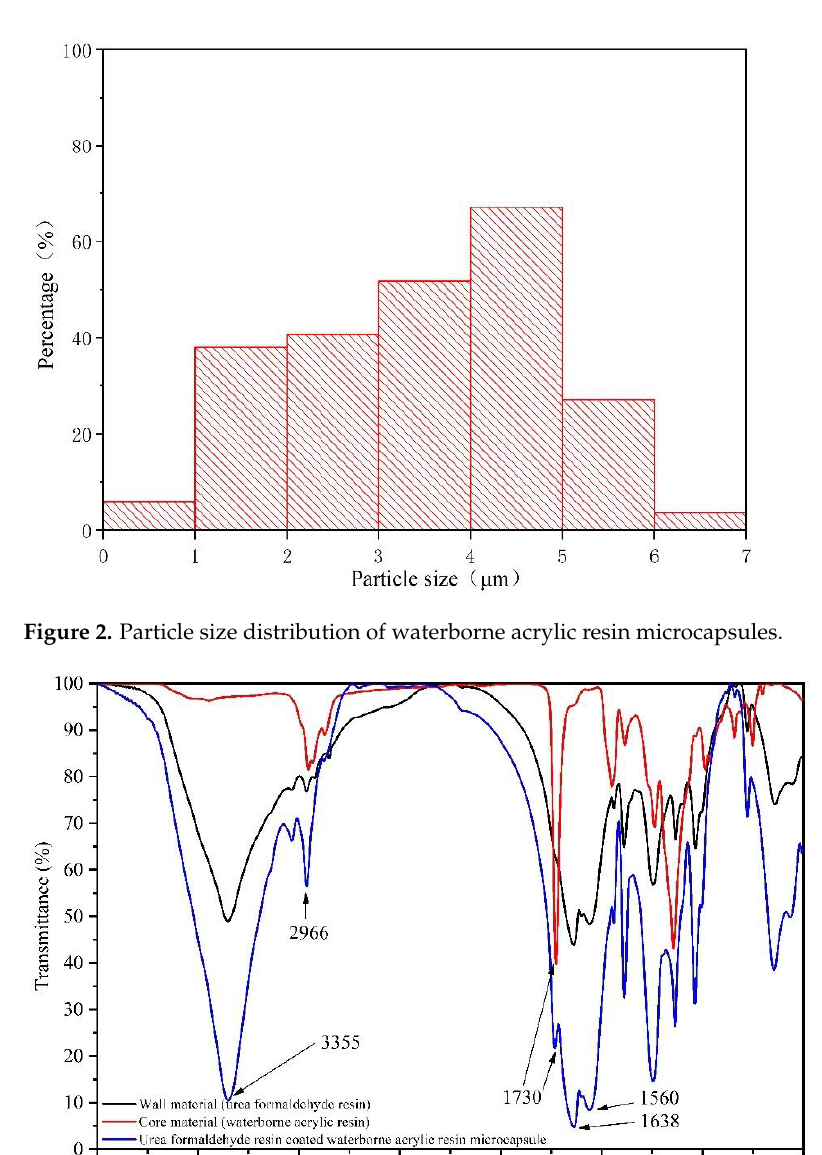
Figure 2. Particle size distribution of waterborne acrylic resin microcapsules.